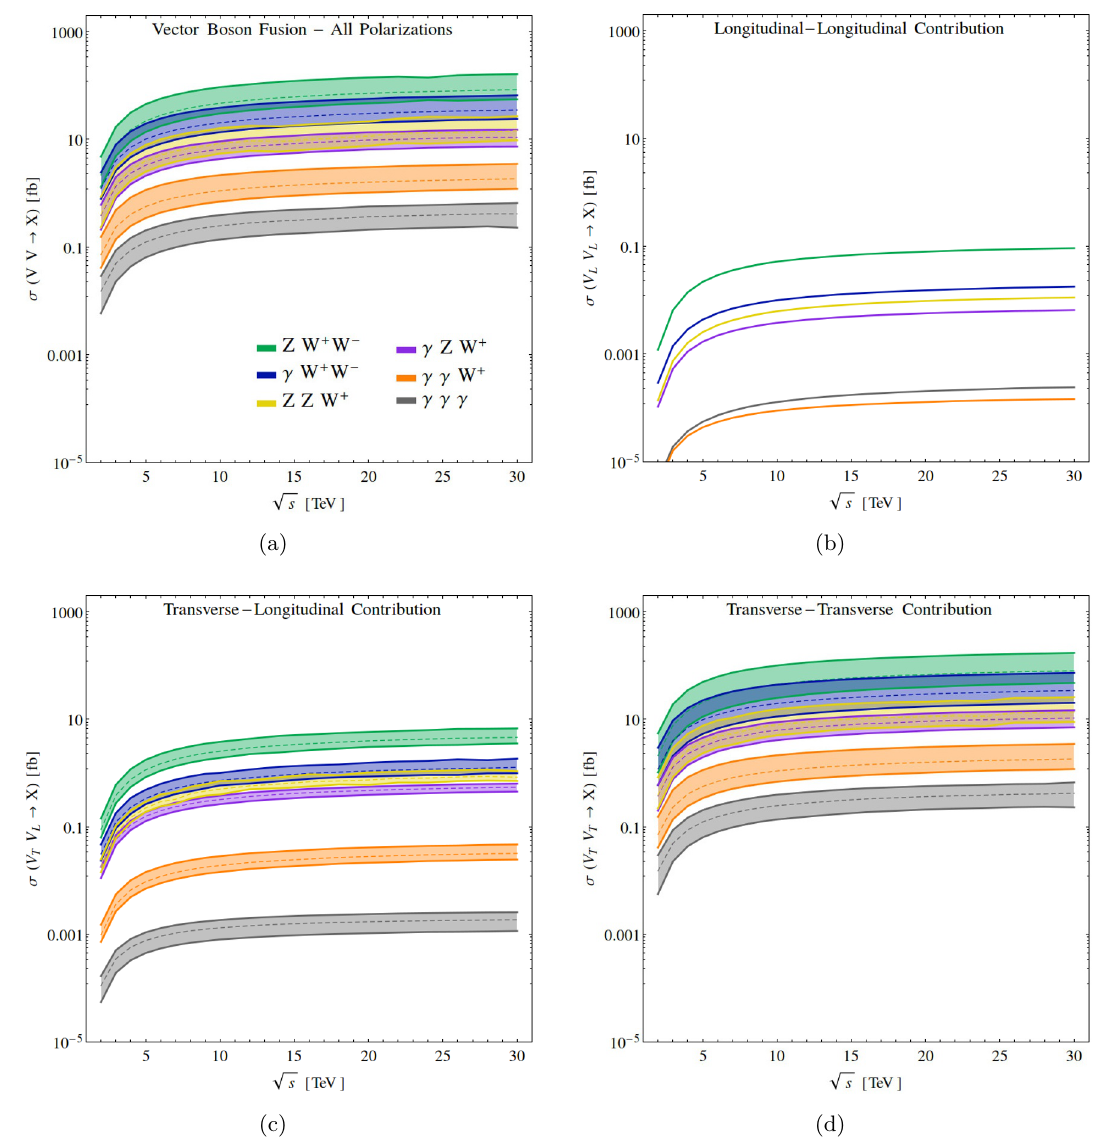
Figure 10 . Same as figure 7 but for V V V